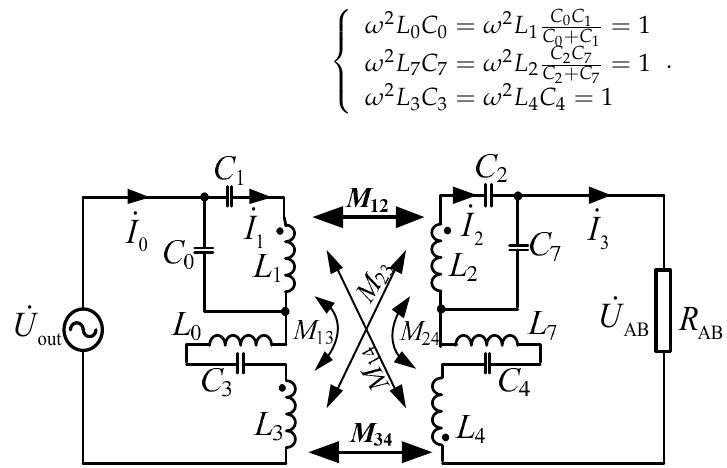
Figure 3. The series hybrid topology driven by a voltage source.